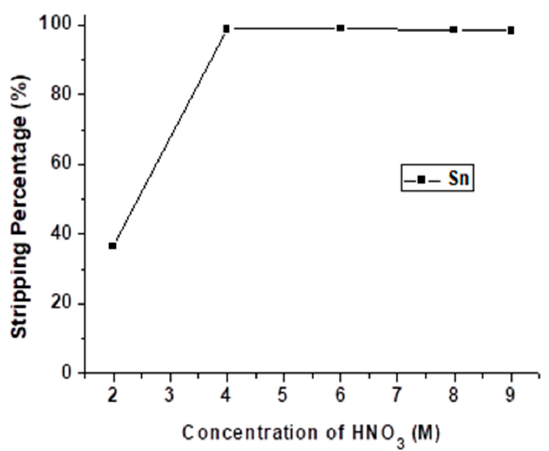
Figure 10. Stripping percentage of Sn at different concentrations of HNO 3 . O/A ratio = 0.5, reaction time = 5 min. time = 5